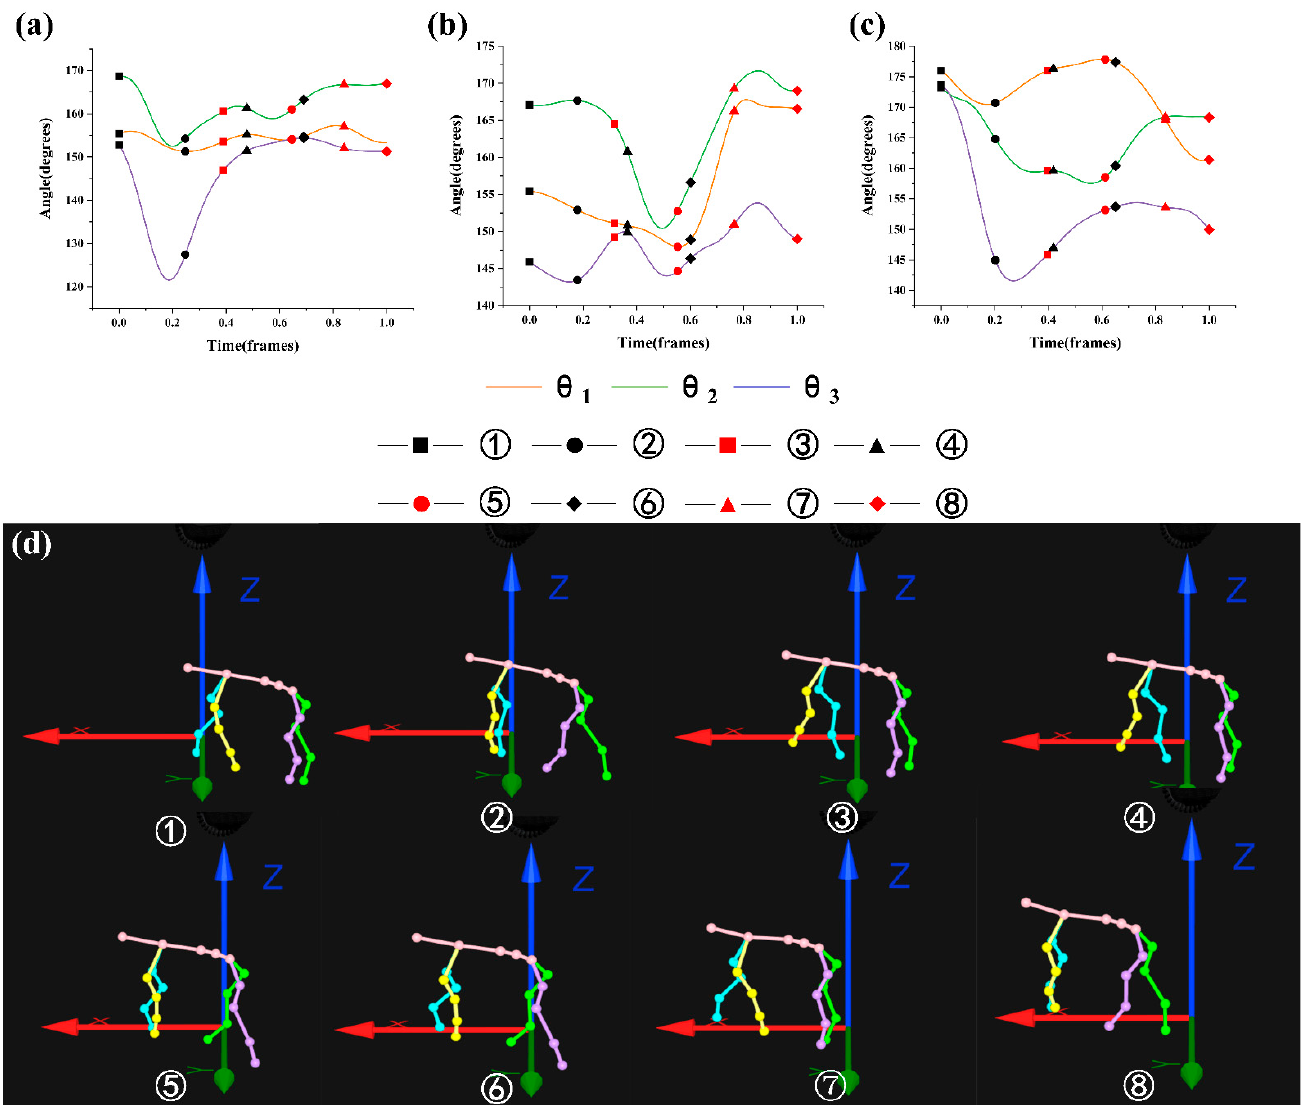
Figure 7. Motion state of goat: ( a – c ) are angle changes of θ 1 , θ 2 , and θ 3 under the slope of 10°; ( d ) eight movements under the slope of 10°.